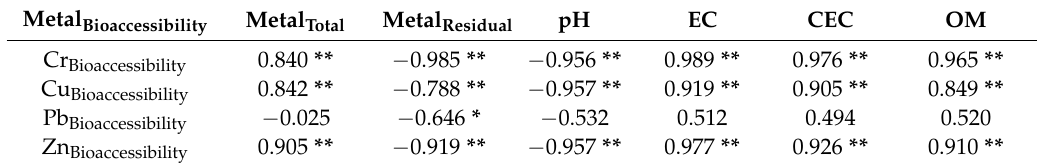
Table 4. Correlation coefficients ( r ) between heavy metal bioaccessibility and total concentration, residual fraction, and physicochemical properties in the control and amended soil ( n = 12).